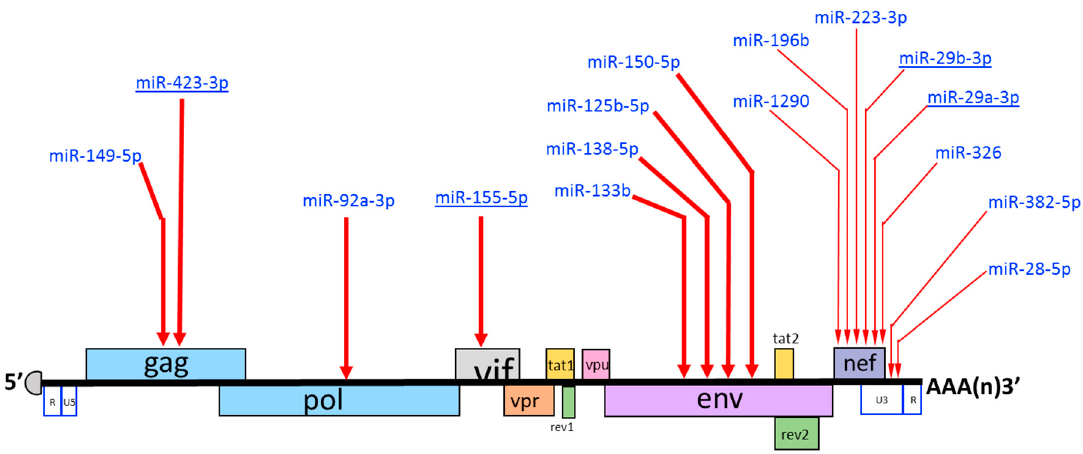
Figure 2. Schematic highlighting the binding sites of cellular miRNAs reported to directly target and bind HIV-1 RNA, and discussed in this review. The cellular miRNAs that are also incorporated into the HIV-1 particles are underlined.